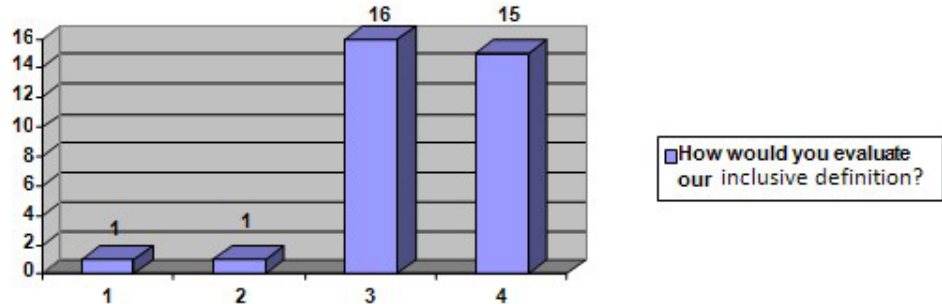
Figure 2. Evaluation of the inclusive definition by the participating